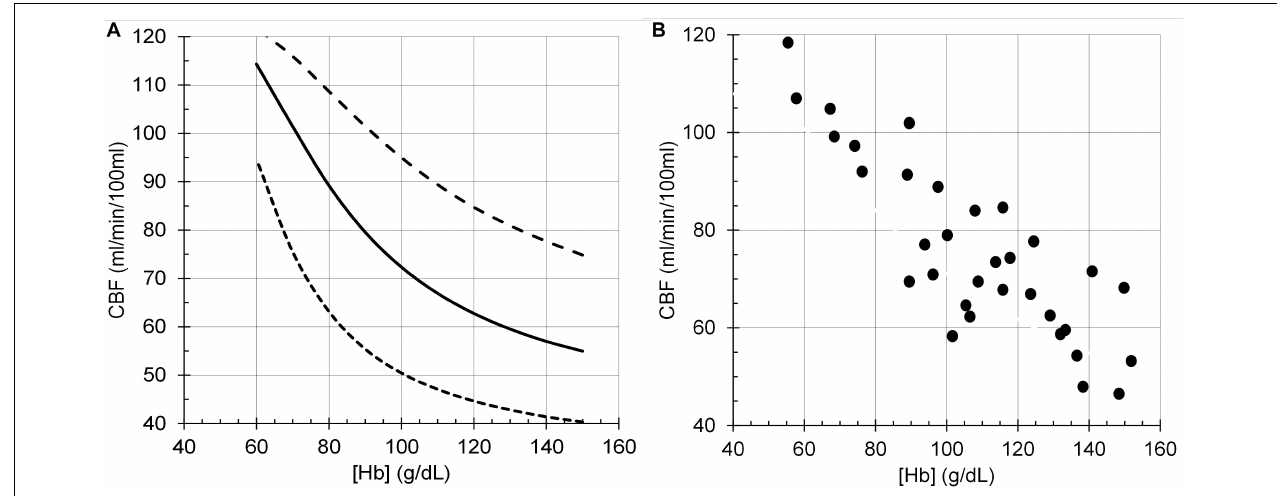
FIGURE 8 | Cerebral blood flow (CBF) responses to anemia ([Hb]). (A) Model responses at PCO 2 = 35 mmHg (dotted line), PCO 2 = 40 mmHg (solid line) and PCO 2 = 50 mmHg (dashed line), and PO 2 = 100 mmHg. (B) Data from young end-stage renal disease adults replotted from Figure 1B of Zheng et al.